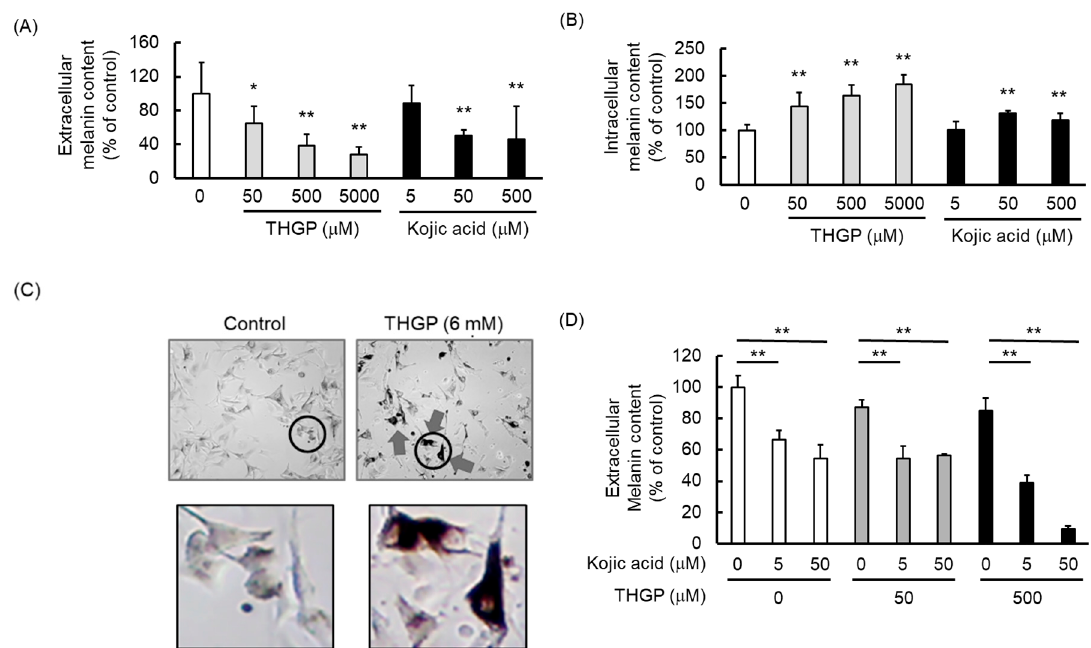
Figure 4. Inhibitory effect of THGP and kojic acid on melanogenesis in B16 4A5 melanoma cells. B16 4A5 cells were treated with THGP or kojic acid for 72 h, and the ( A ) extracellular and ( B ) intracellular melanin amounts were then evaluated. ( C ) Optical microscopy images of cells treated with THGP (6000 µ M). The arrow means melanin accumulated in large amount in B16 4A5 and the circle means the enlarged location in the figure below. ( D ) The suppressive effect of the combination of THGP and kojic acid on melanin synthesis was evaluated. The results were statistically analyzed using Dunnett’s method, and 0 µ M THGP served as the control. The data are presented as the means ± SDs from six independent experiments. * p < 0.05 and ** p < 0.01 vs. the control.